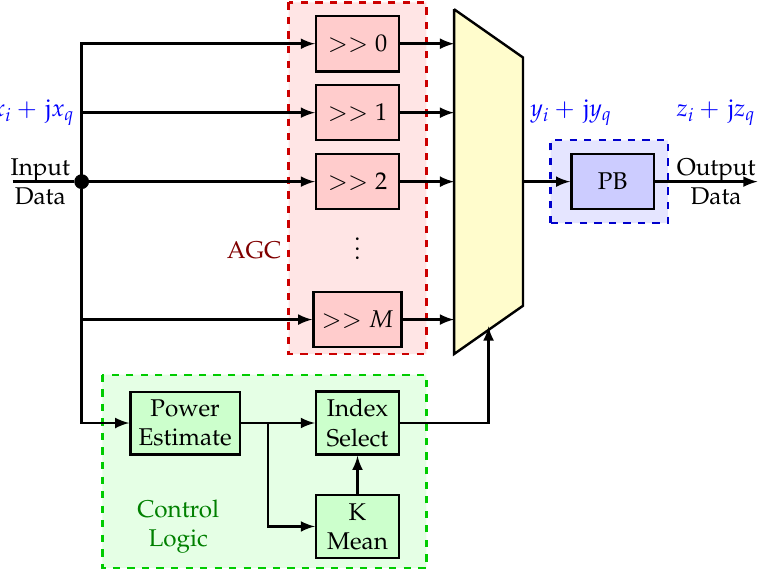
Figure 2. AGC module block diagram. ©IEEE. Reprinted, with permission, from [11]. Third, the control logic drives a multiplexer (yellow multiplexer, center) which selects the appropriate AGC channel. The in-phase y i [ n ] and quadrature-phase y q [ n ] output of the AGC stage is then defined